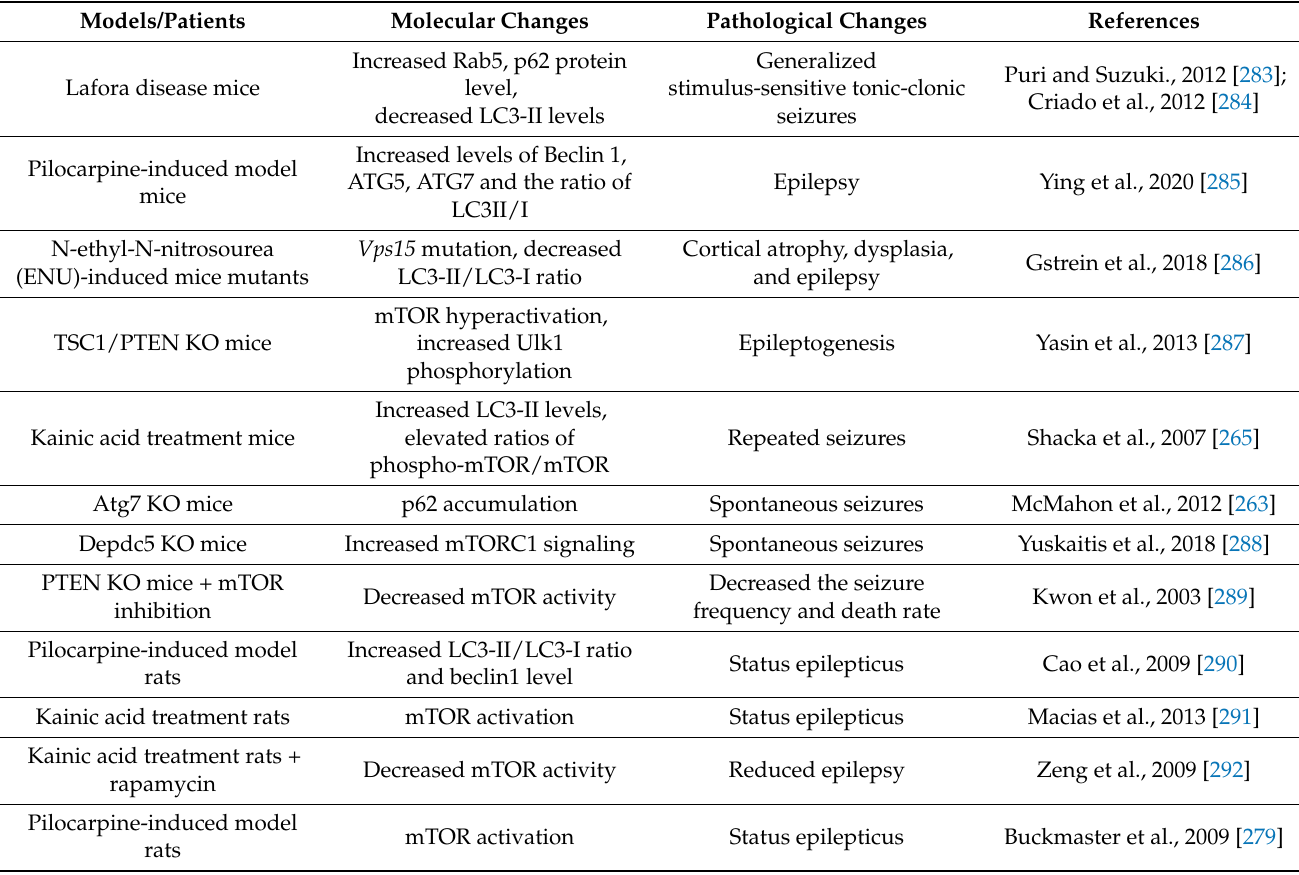
Table 1. The autophagy-related molecular changes in epilepsy animal models and patients.